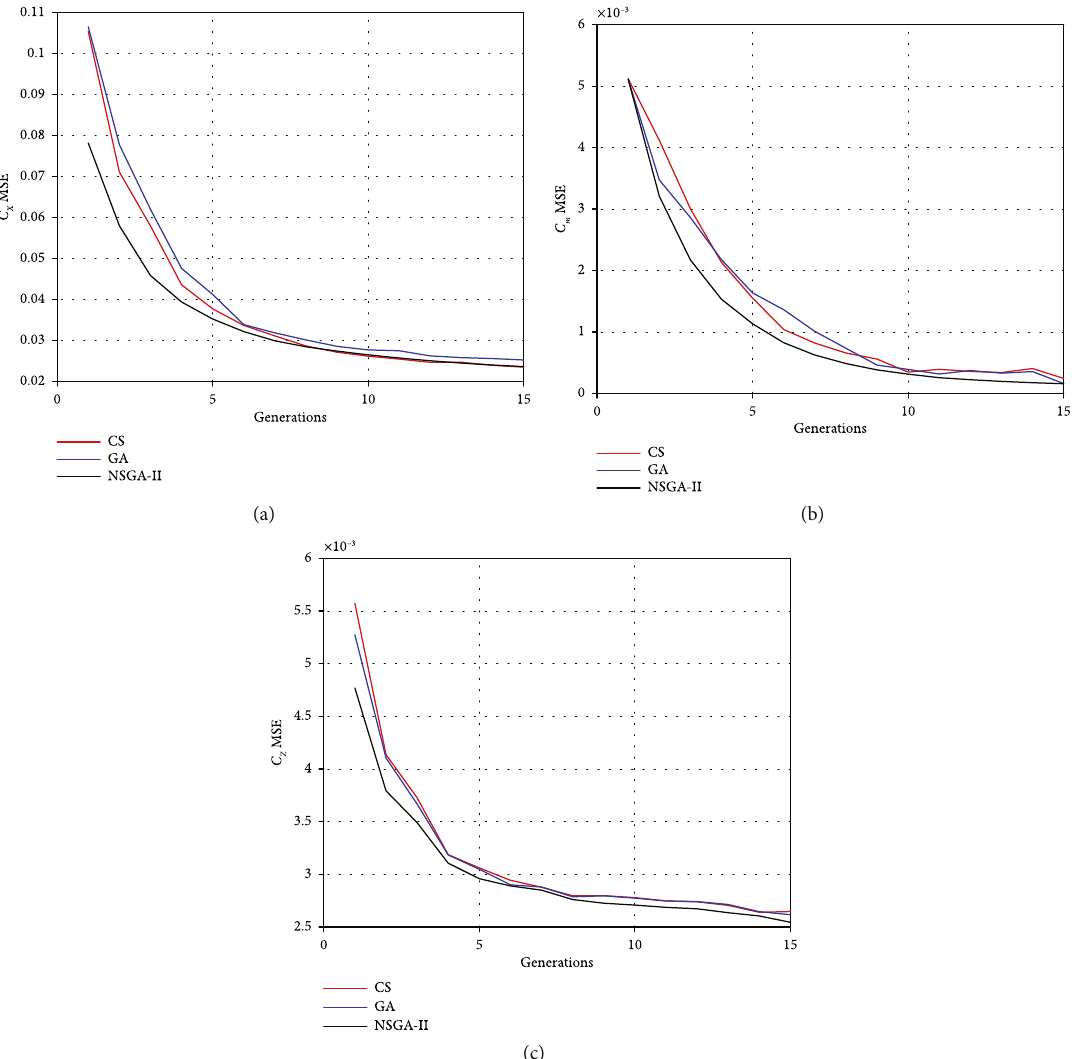
, (b) C , and (c) C . X m Z